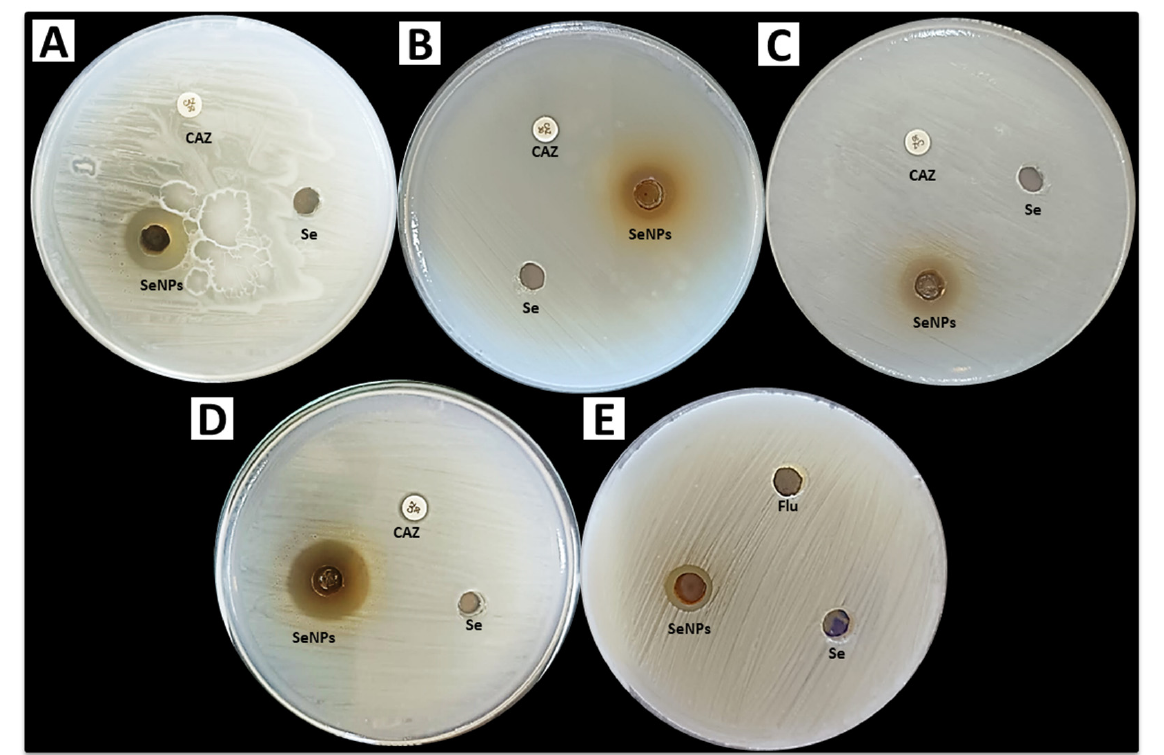
Figure 7. Antimicrobial activity of mycosynthesized SeNPs and sodium selenite (Se) against E. coli Table 1. Inhibition zones of mycosynthesized SeNPs against all tested microbial strains. Inhibition Microbial Strain